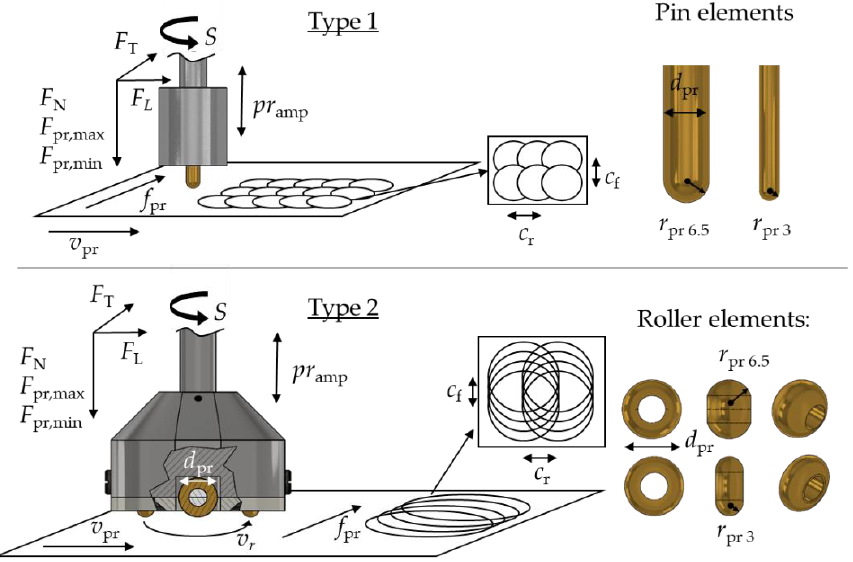
Figure 2. Parameters of pulsed mechanical surface treatment.